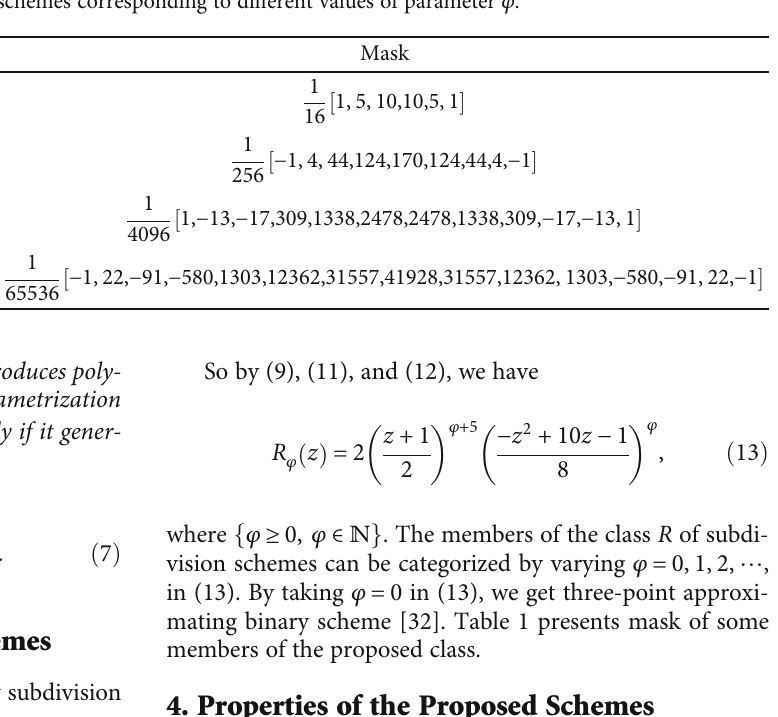
ff erent values of parameter φ